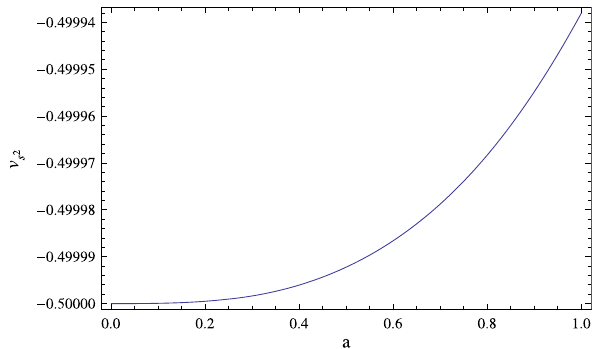
Fig. 9 Variation of speed of sound for GDE with a physical parameters of GGDE in this article. Again the value of β has been found to be negative which indicates that sub- leading term has negative contribution to the energy